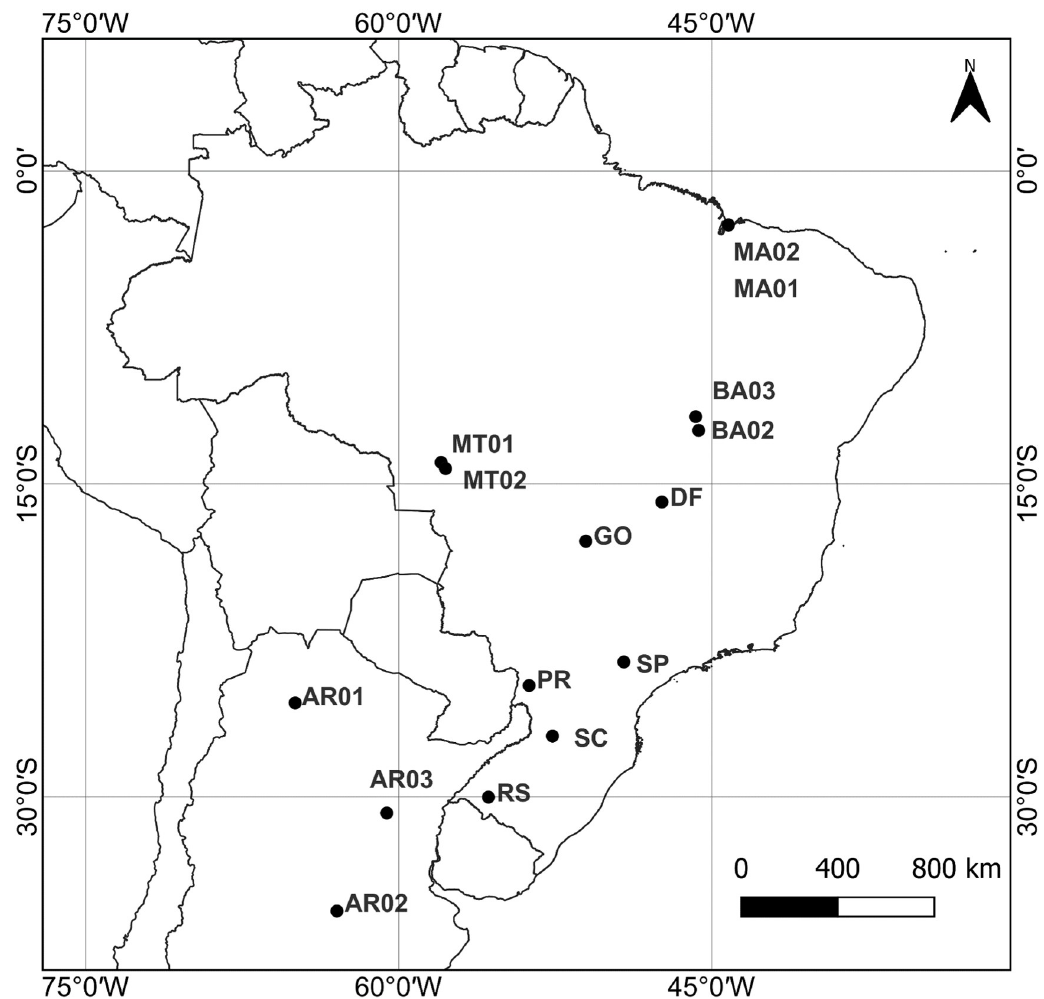
Fig 1. Fall armyworm sampling locations in Brazil and Argentina according to ecoregions. Shapefile of limits of countries in South America: IBGE-Mapas (IBGE—Brazilian Institute of Geography and Statistics; Available at: < https://geoftp.ibge.gov.br/ cartas_e_mapas/bases_cartograficas_continuas/bc250/versao2021/shapefile/bc250_shapefile_2021_11_18.zip > ; Acessed on February 26, 2023) QGIS v3.28.3 (Available at: < https://qgis.org/en/site/ > ; Acessed on: February 26, 2023). DATUM: SIRGAS